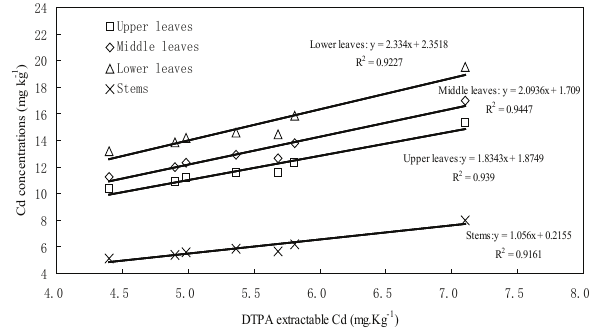
Figure 3: Relationship between pH of soils with different zeolite treatments and soil available cadmium content.